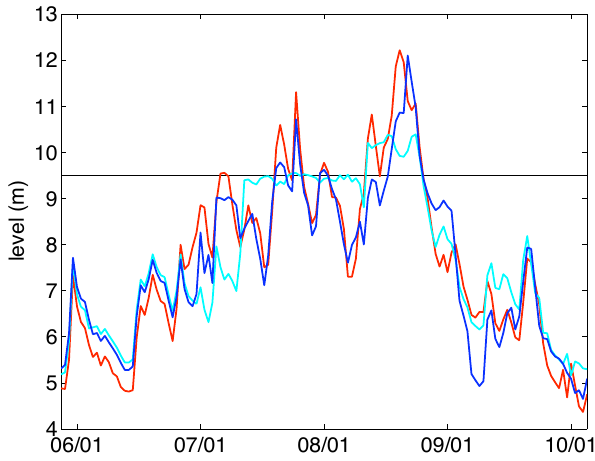
Fig. 5. Water level in Hanoi in the 1996 flood season (June to September) under historical operation (red), MOGA-19 policy (blue) and by DDP-21 (cyan). The black line is the flooding thresh- old in Hanoi.